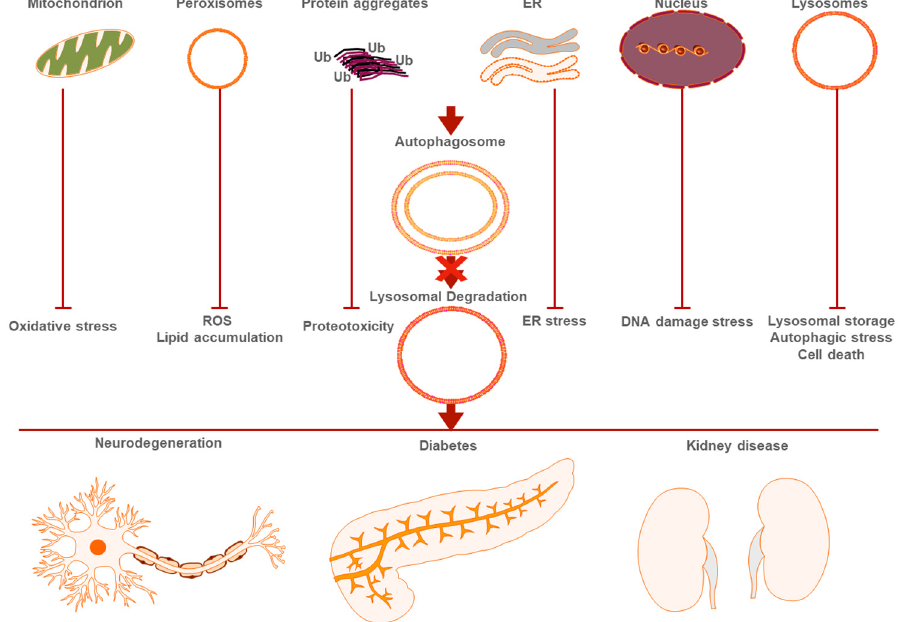
Figure 1. Perturbation of selective autophagy triggers age-related disease. Autophagic degradation of organelles (mitochondria, peroxisomes, ER, nuclei, lysosomes) and protein aggregates leads to loss of cellular homeostasis and subsequent pathological conditions.